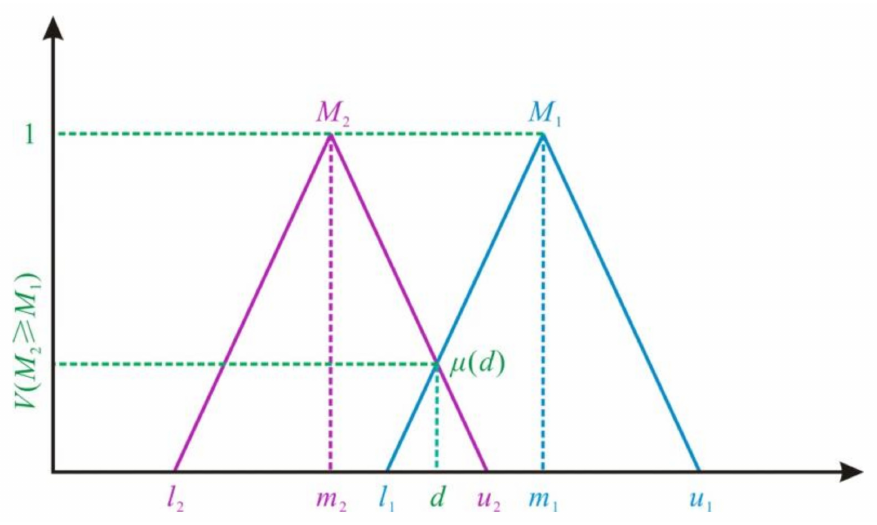
Figure 9. Possible degree of two triangular fuzzy numbers µ ( M 2 ≥ M 1